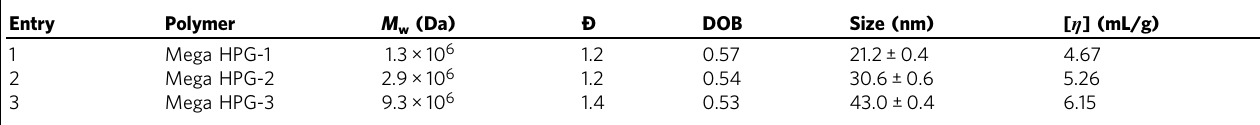
Absolute molecular weight ( M w ) and distribution ( Đ ) of mega HPGs was con fi rmed by size-exclusion chromatography coupled with light scattering detector (MALS). Degree of branching (DOB — 53- 57%) supports the semidendritic nature of the polymers and it was determined by 13 C IG NMR spectroscopy. Mega HPGs are compact in size and have low intrinsic viscosity [ ƞ ], determined by quasielastic light scattering (QELS) detector and viscometer-II detector, respectively, which are coupled to a gel permeation chromatography